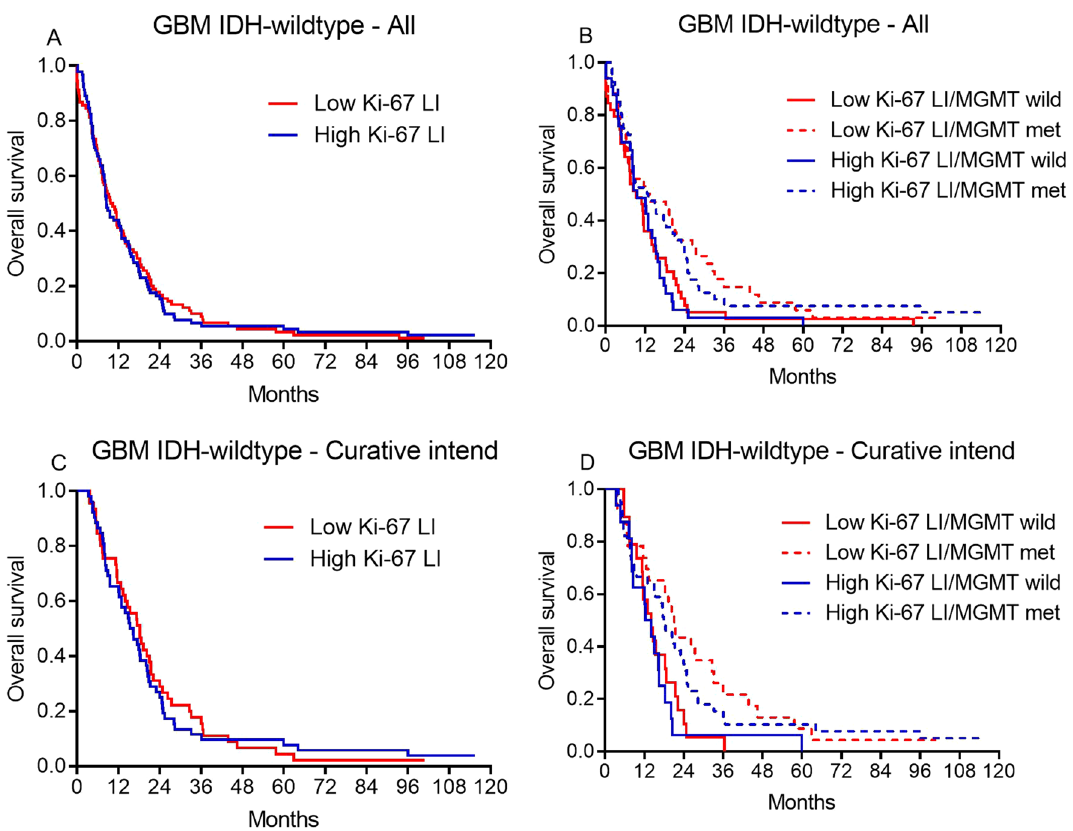
Figure 3. Kaplain Meier curves shown for all patients ( A ) and patients with known MGMT promoter status ( B ). Similar curves are shown for patients receiving radiotherapy 59.4 Gy on 33 fraction and concomitant and adjuvant Temozolomide in ( C ) and ( D